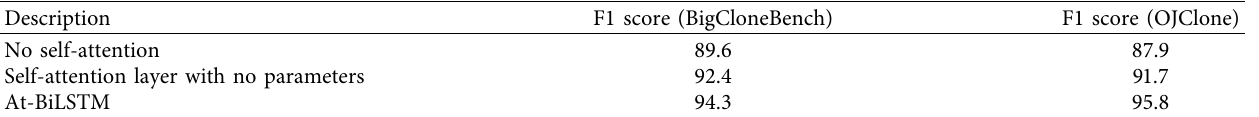
Table 4: Clone detection models with various self-attention layers